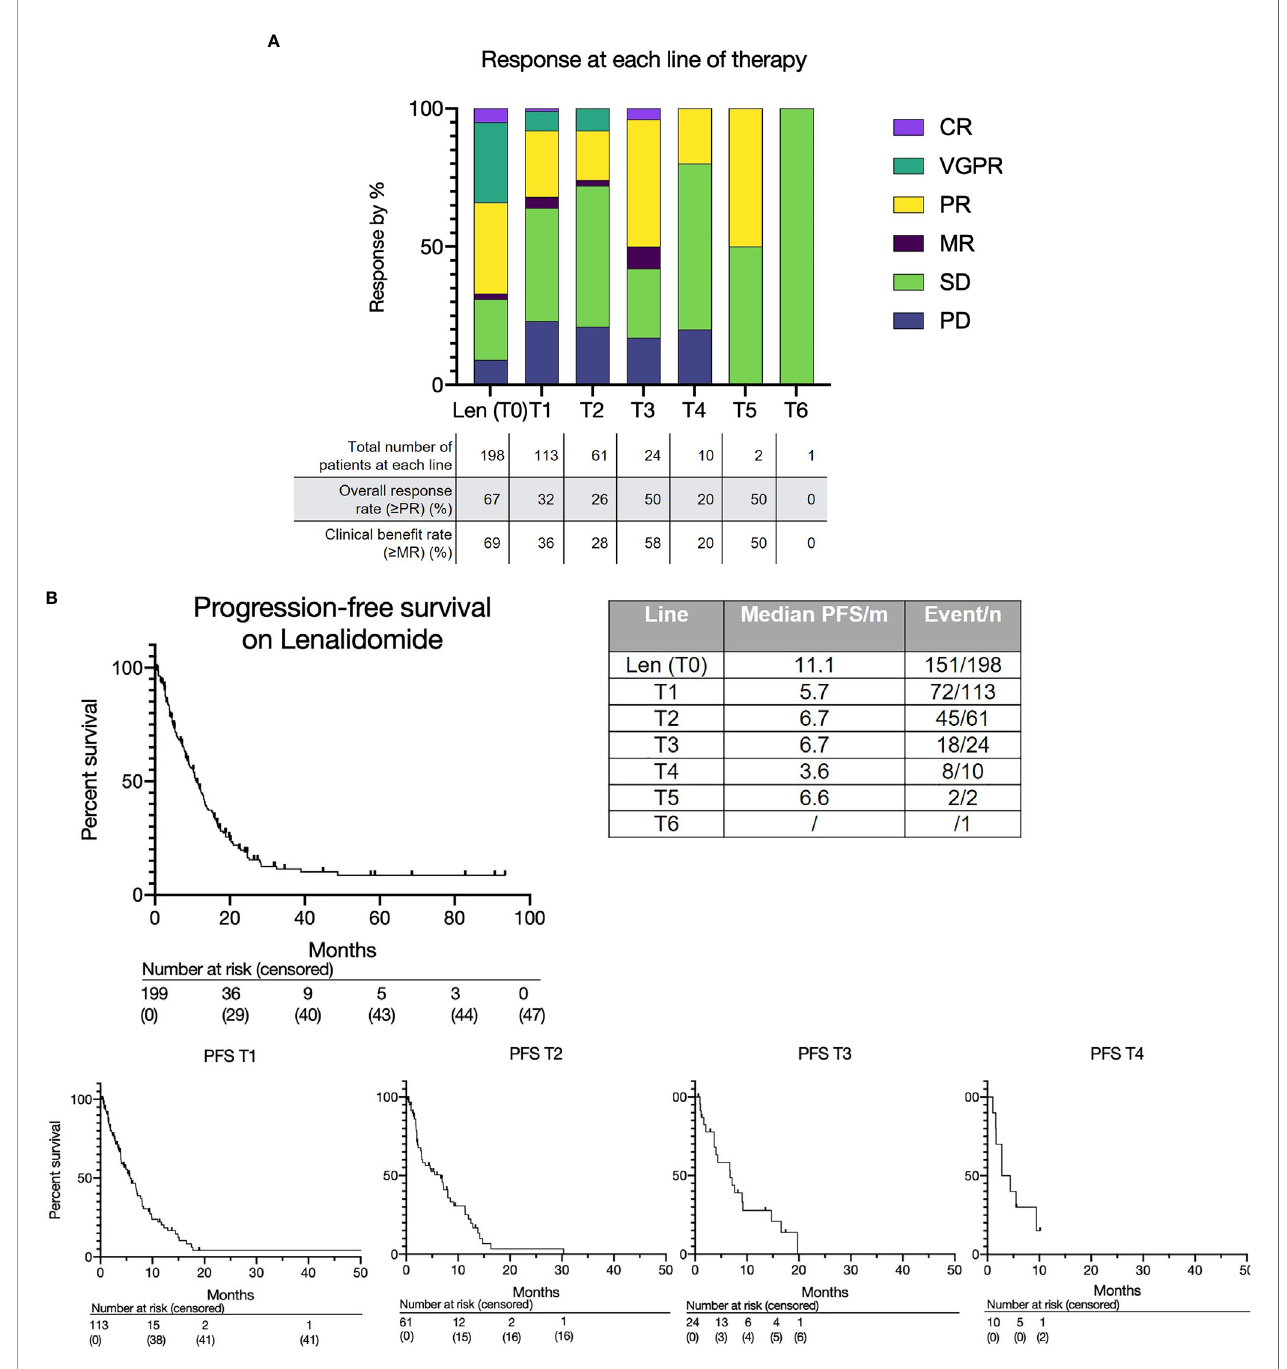
FIGURE 1 | (A) Treatment response to lenalidomide-based treatment and subsequent lines of therapy. (B) Progression free survival for lenalidomide-based therapy (T0) and each subsequent line (T1, T2, T3